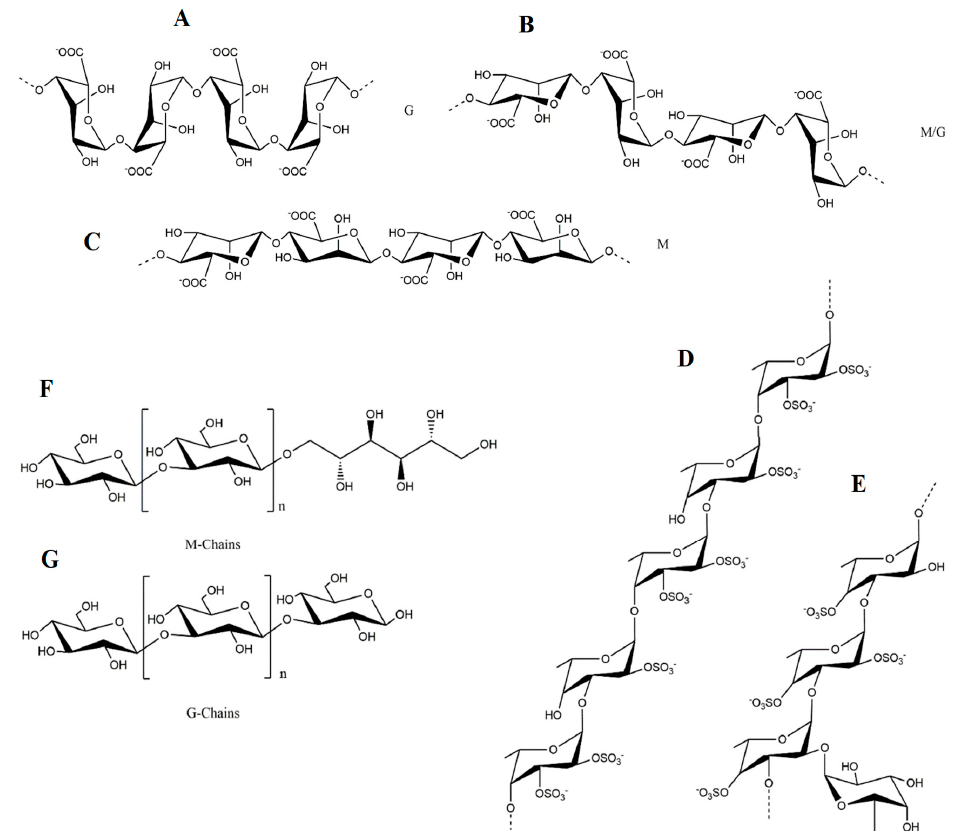
Figure 1. The structure of representative polysaccharides found in brown algae: ( A – C ) alginic acids; ( D – E ) fucoidans from A. nodusum / F. vesiculosus and S. latissima , respectively; ( F – G ) laminarins M and G chains.